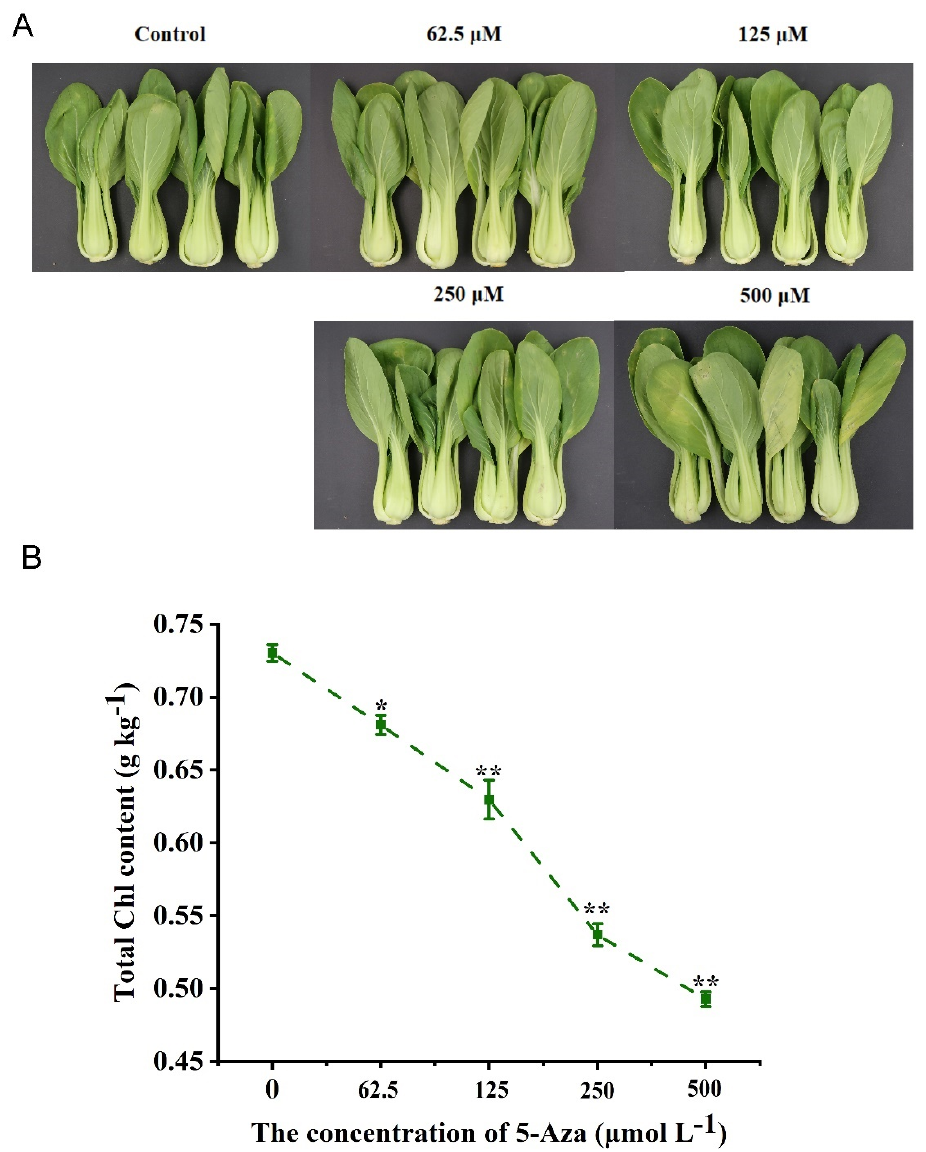
Figure 2. The phenotypic characteristics ( A ) and the changes of total Chl content ( B ) of pak choi treated with different concentrations of 5−Aza at 20 ± 1 °C. The data in the figure are the mean ± SD of three biological replicates. The asterisks in the figure indicate significant differences between the mean values of different concentrations (* p < 0.05; ** p < 0.01).